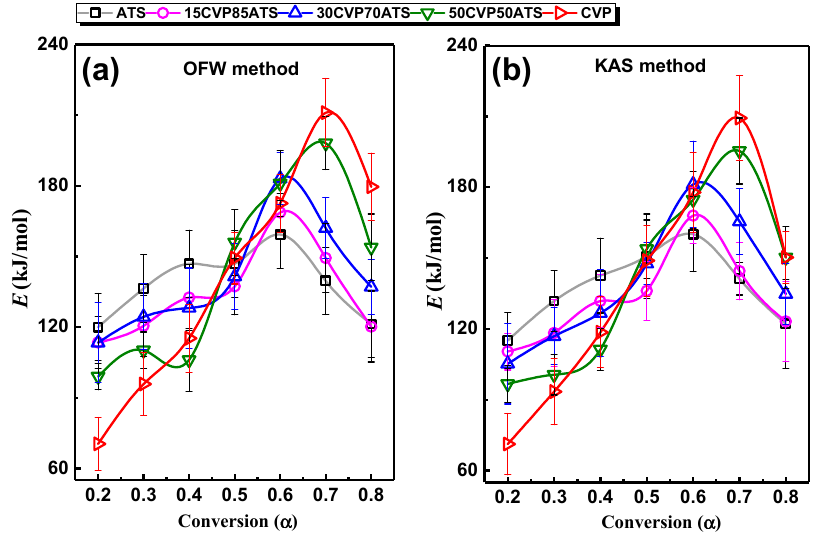
Figure 12. Relationship between the E and different α determined by ( a ) OFW and ( b ) KAS.